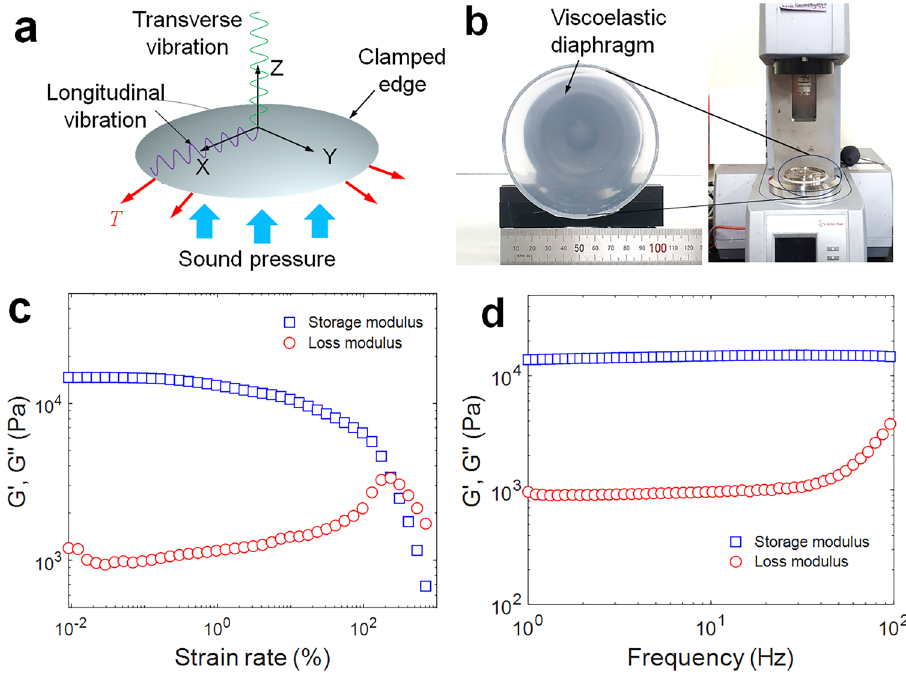
Figure 2. Viscoelastic acoustic diaphragm: ( a ) schematic model, ( b ) photograph, ( c ) storage and loss modulus vs strain rate, ( d ) storage and loss modulus as a function of